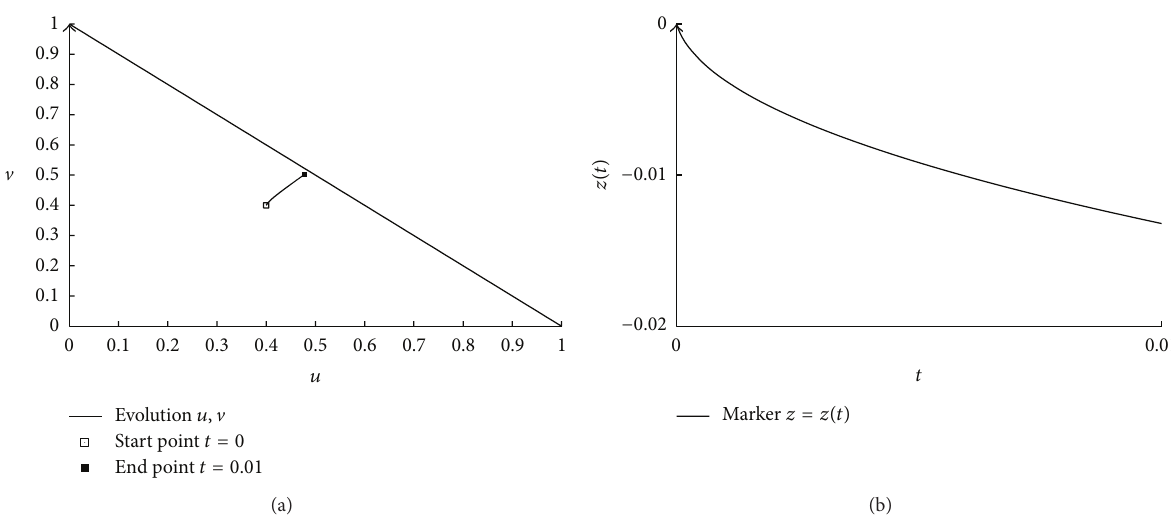
Figure 2: Evolution of concentrations 𝑢 , V (a) and experimental position of marker 𝑧 = 𝑧(𝑡) for 0 ≤ 𝑡 ≤ 0.01 (b).